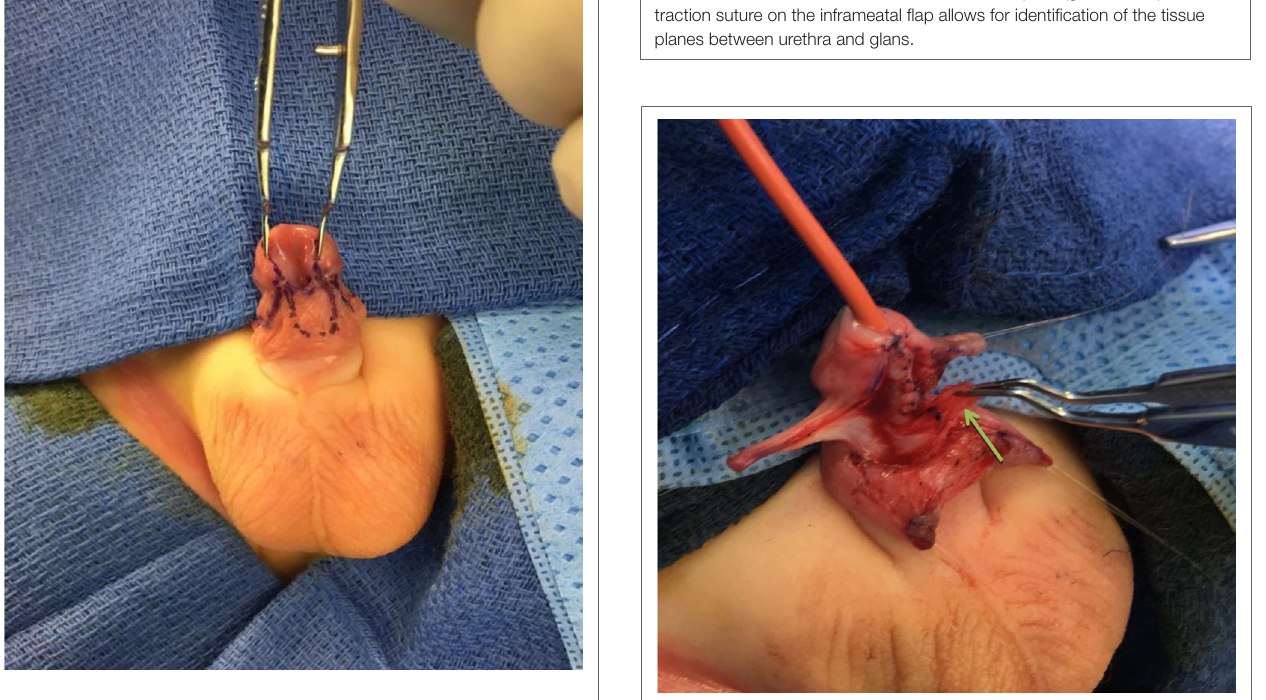
FigUre 3 | The inframeatal flap has been deepithelialized and is rotated superiorly to cover the reconstructed urethra (green